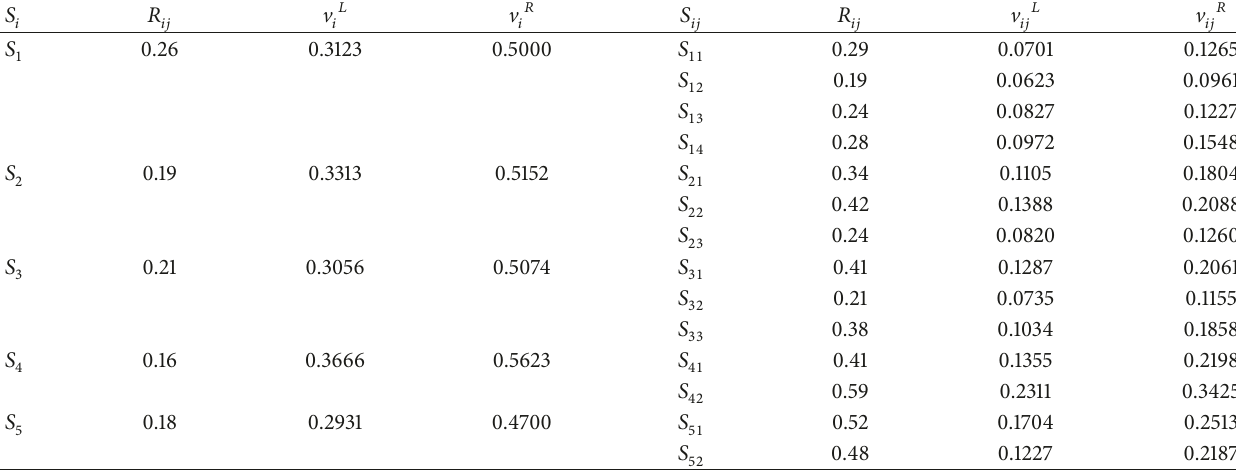
Table 8: Evaluation index